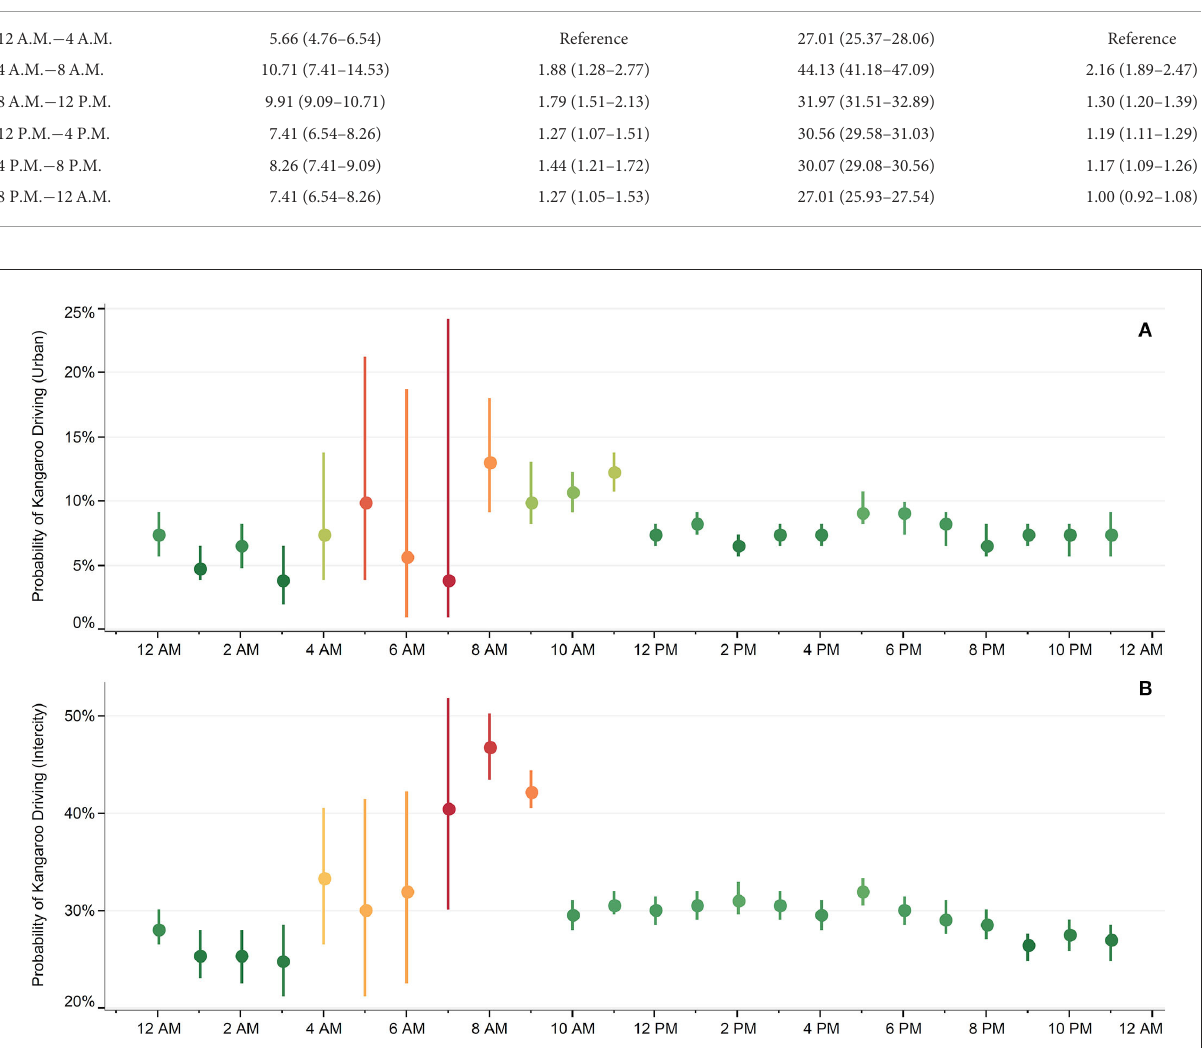
risk of RTIs in areas with lower existence of traffic lights (40).